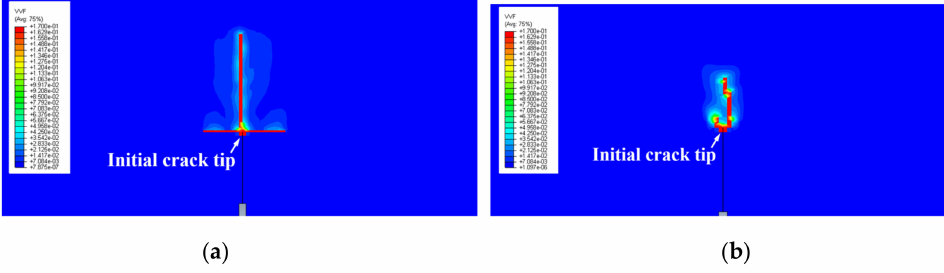
Figure 8. The typical crack propagation paths when 0.6 times ( a ) and 0.8 times ( b ) the true stress versus strain curves of the ductile material A508 were assigned to the left region and the right